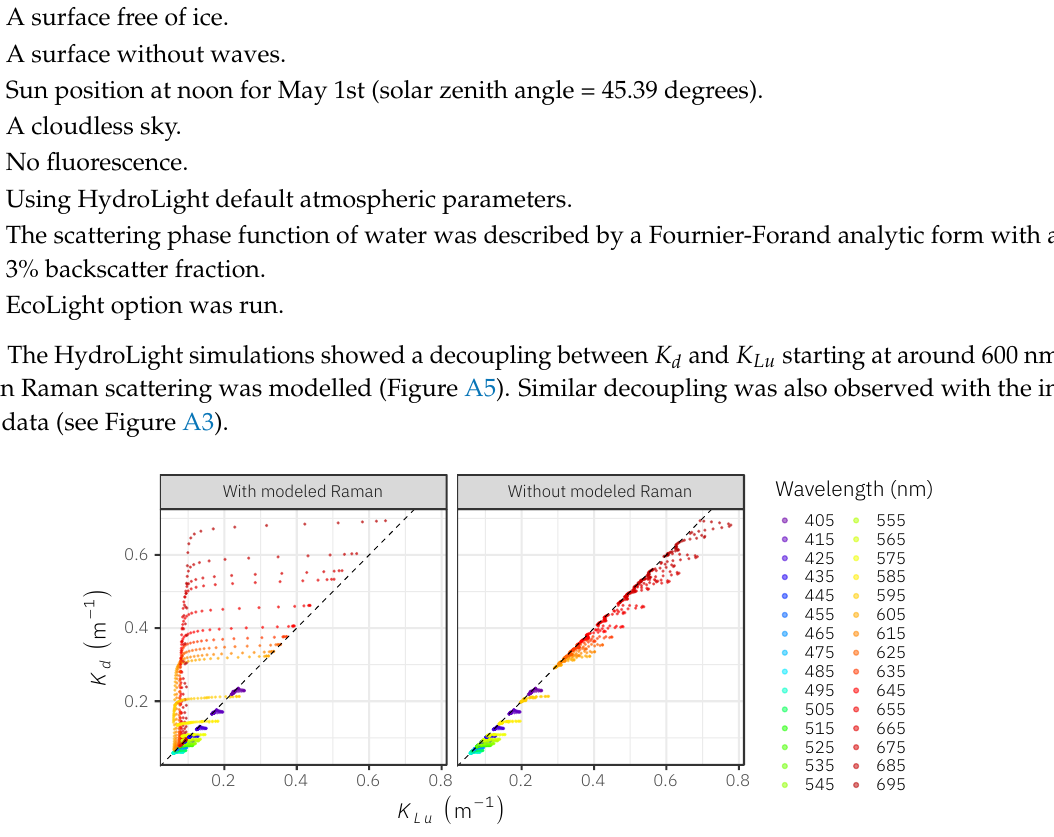
Figure A5. Scatter plots showing the relationships between K d and K Lu calculated from the downward irradiance and upward radiance profiles modelled with and without Raman scattering. The dashed lines represent the 1:1 lines.